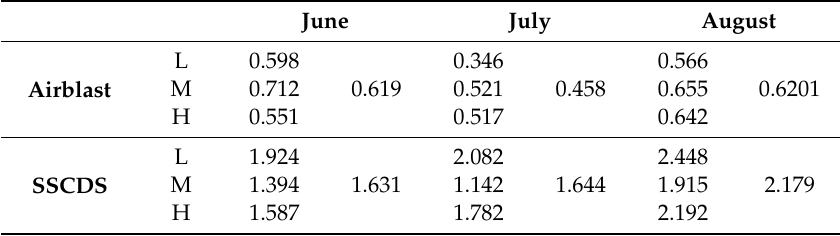
Table 4. Coe ffi cient of Variation of abaxial coverage (cm 2 ) for each date and height. Least square mean of each treatment, height, and date combination on the left and least square mean of the overall date and treatment combination to the